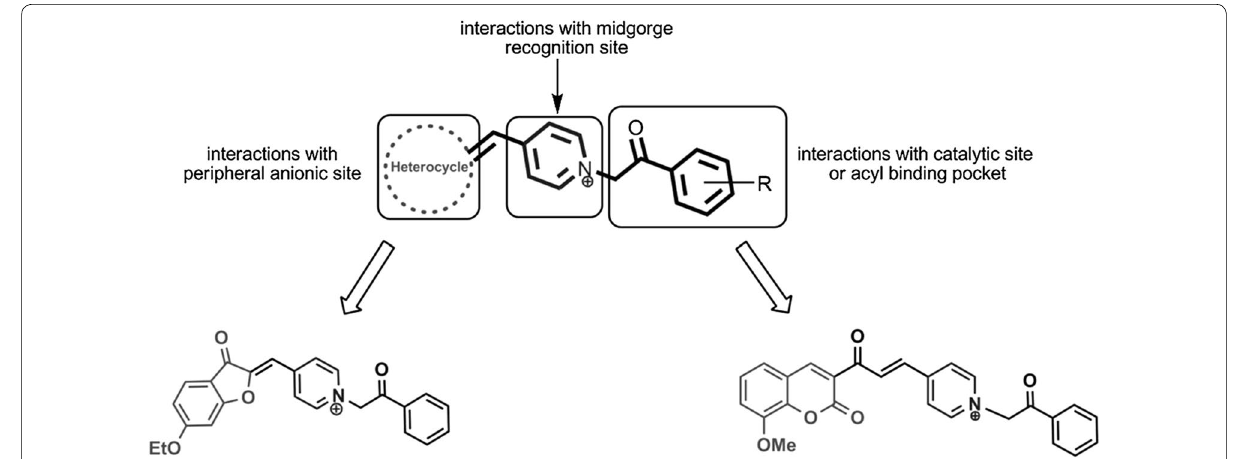
Fig. 33 Designed structures as potential inhibitors of AChE and BuChE [50]